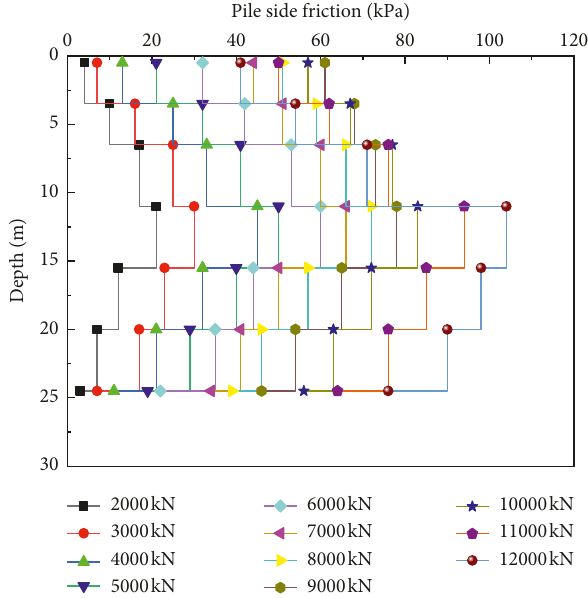
Figure 9: The pile side friction curve of the test